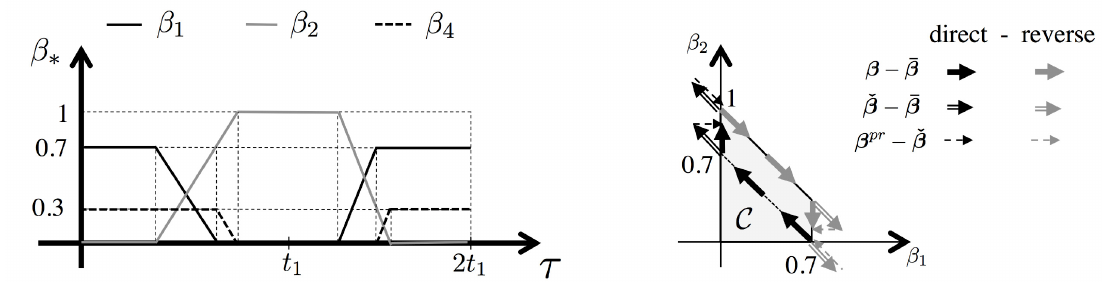
Figure 6: Alloy composition vs. time (left) and in the volume fraction space (right) predicted by present model for a traction loading- [0,2 ] t  ) considering a SMA with initial mixture martensitic-austenitic composition unloading test (see applied strain in Fig. 2 for 1 with = (0) = (0.7,0,0) in t β β (dimensions of arrows are not in